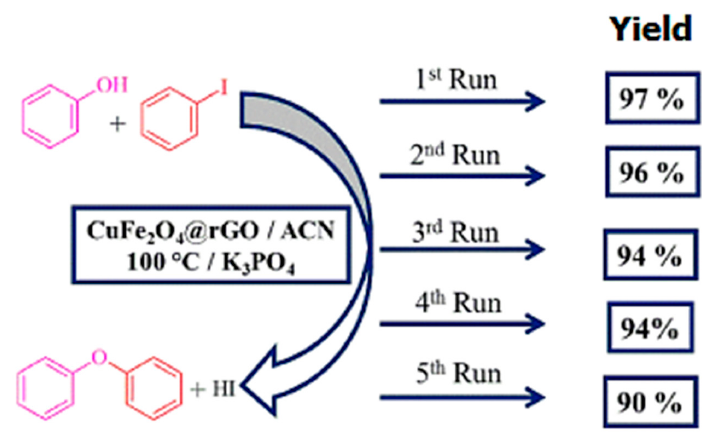
Figure 8. The reusability of the synthesized catalyst and the yield of ether product.